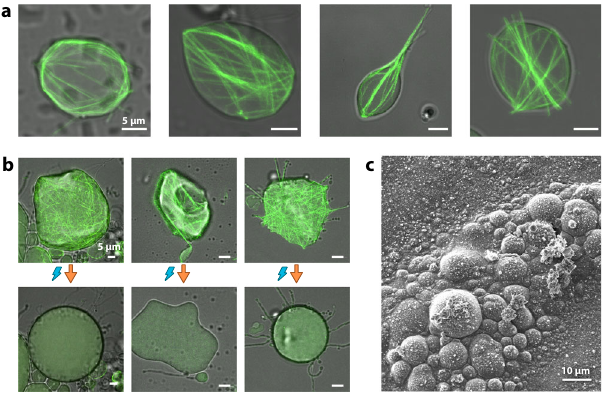
Fig. 6 Actin network governs vesicle shape in osmotically de fl ated vesicles. a Variety of vesicle shapes produced by different morphologies of encapsulated actin networks, some with stabilizing cortices and others with fi lopodia-like membrane protrusions. b Upon exposure to photodamage through increased laser power, cytoskeletal vesicles lose their stabilizing actin cortex, and often take on a fl at and round shape. All three examples are shown in Supplementary Movie 7. c Vesicles with a stabilizing arti fi cial actin cortex can be dried, frozen, and imaged using cryo-scanning electron